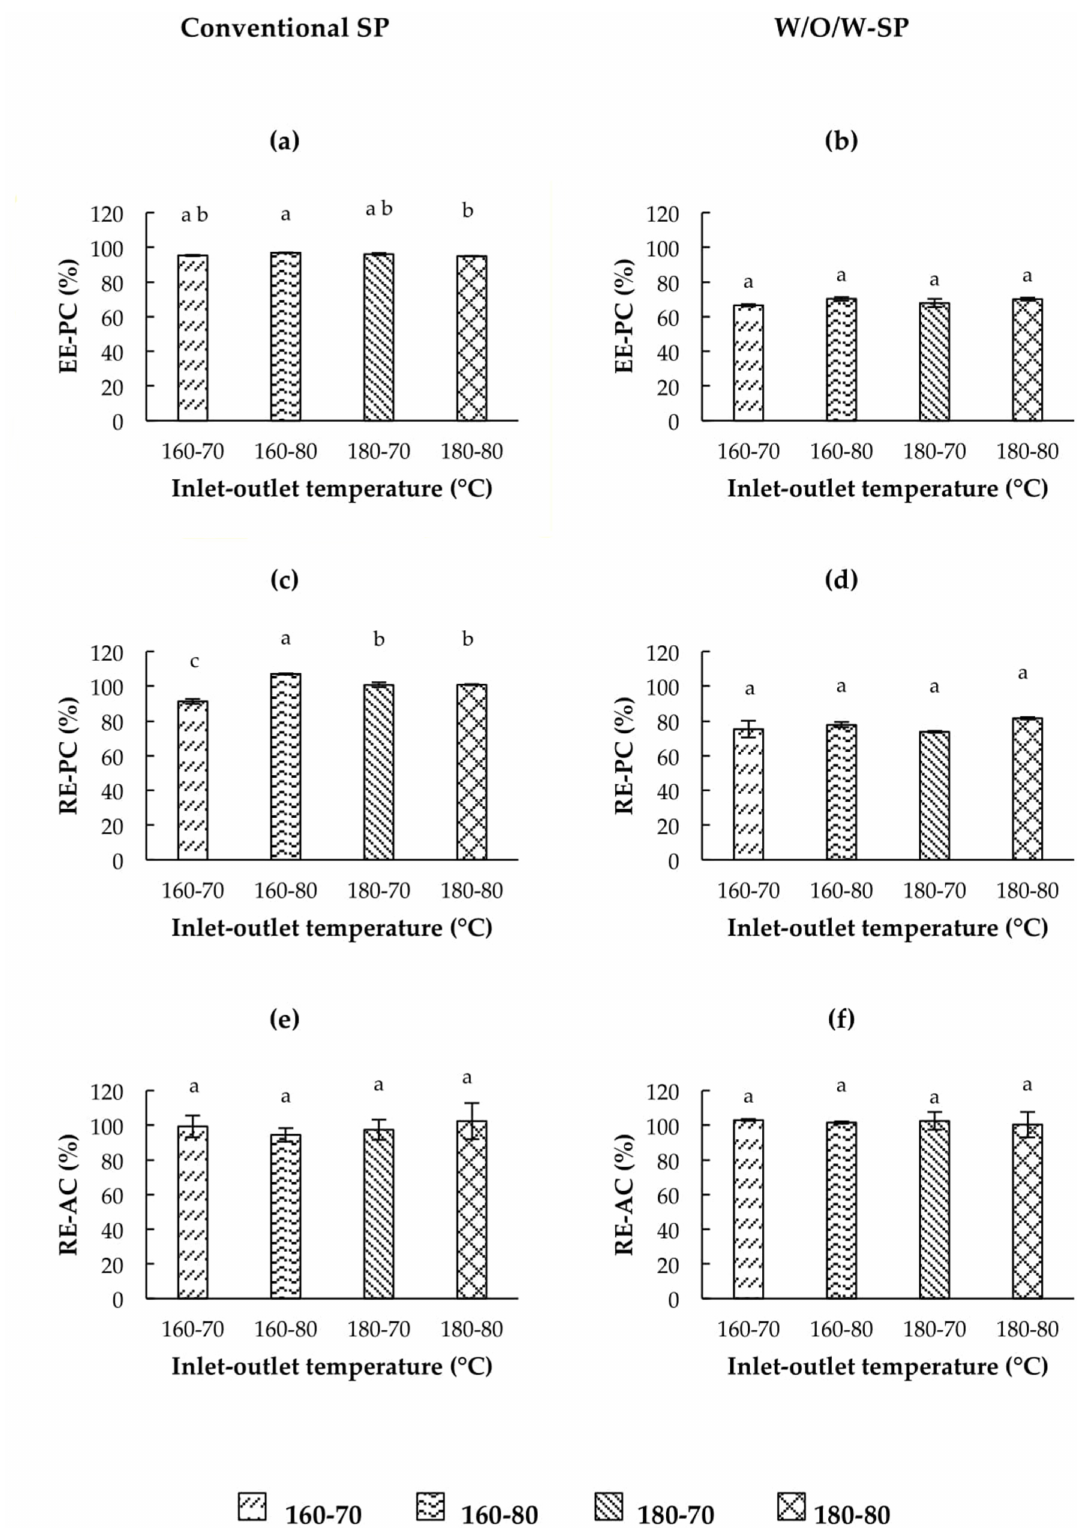
Figure 2. Conventional spray drying (SP) and double emulsions-spray drying (W/O/W-SP) microencapsulation histogram graphs of: ( a , b ) encapsulation efficiency of PC (EE-PC, %); ( c , d ) retention efficiency of PC (RE-PC, %); and ( e , f ) retention efficiency of AC (RE-AC %), respectively. Results are expressed as the mean ± standard deviation, n = 2. Identical vertical scales are used for comparison. Different letters indicate significant difference ( p <